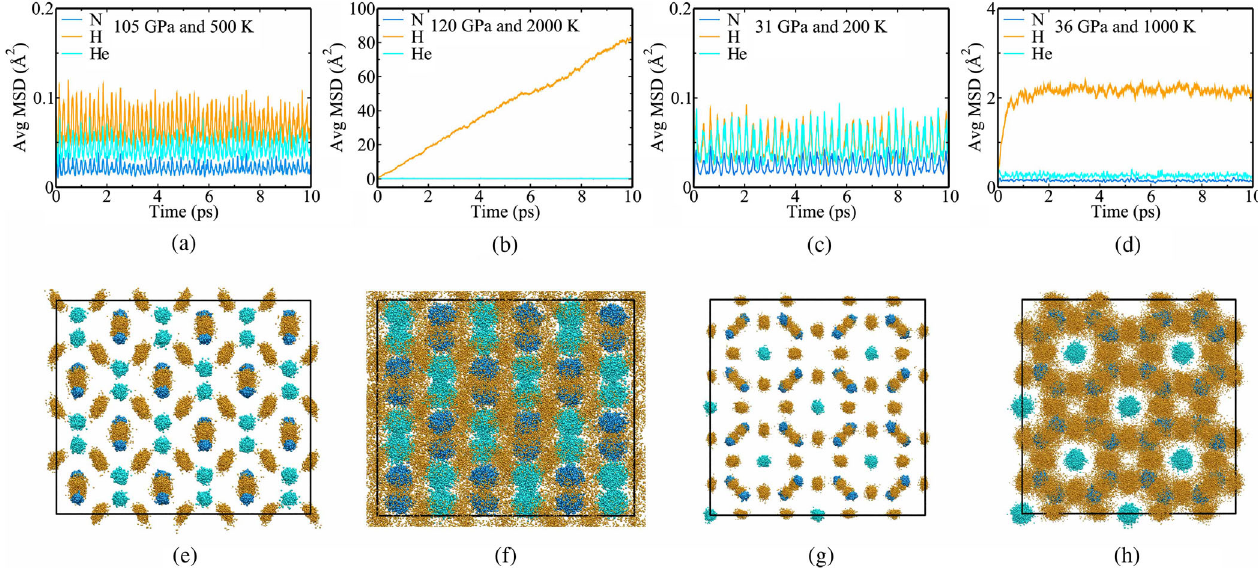
FIG. 2. Dynamical behavior of H (green) and He atoms (cyan) compared to N atoms (blue) in the helium ammonia compounds under high pressure and temperature. AIMD simulations were performed at 105 GPa and 500 K, 120 GPa and 2000 K for the Pnma HeNH 3 phase, and at 31 GPa and 200 K, 36 GPa and 1000 K for I 4 cm He ð NH 3 Þ 2 . (a) – (d) The averaged mean-squared displacements (MSD) at different temperatures. (e) – (h) Atomic trajectories from the simulations representing three different states of matter: the solid Pnma HeNH 3 phase (500 K), the superionic phase (2000 K), the solid I 4 cm He ð NH 3 Þ 2 phase (200 K), and the plastic phase (1000 K); the liquid phase is not shown. The N, H, and He atoms are respectively plotted with blue, green, and